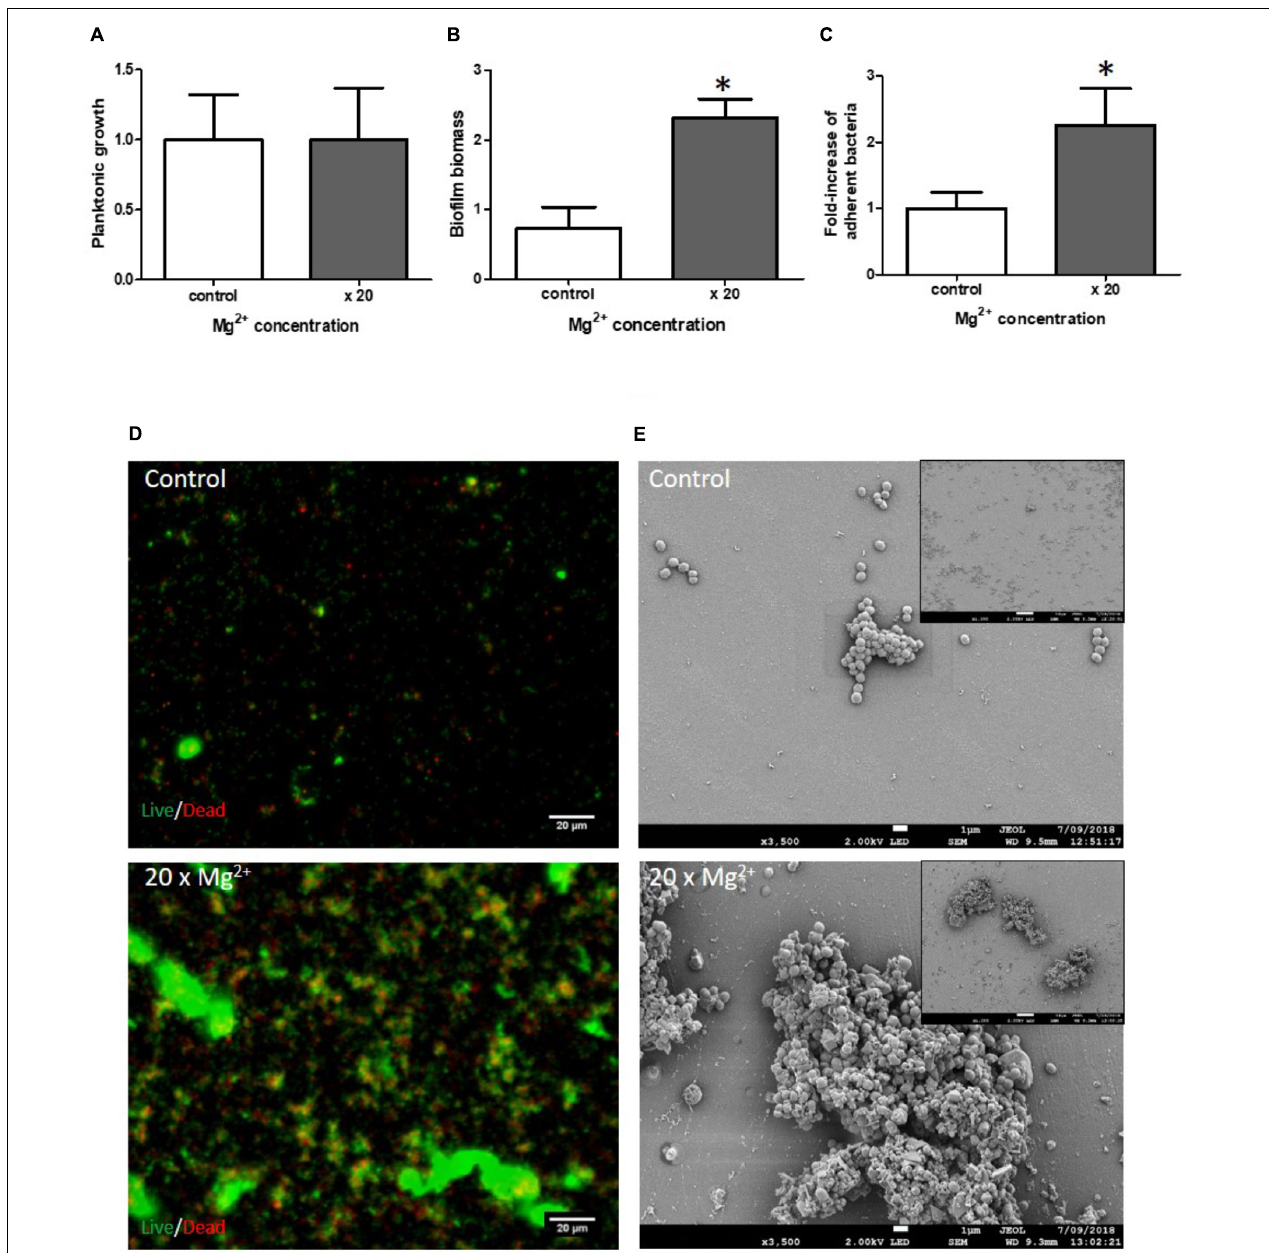
FIGURE 2 | Impact of Mg 2 + on S. aureus biofilm formation. Planktonic growth normalized to control (A) ; biofilm biomass quantified by crystal violet staining (B) and fold-increase of live adhered cells (C) . Mg 2 + × 2 (control) and × 20 serological concentration (=1 mM). ( n = 9). ∗ Statistically significantly different from control ( p < 0.05). Fluorescence microscopy (D) with live (green color)/dead (red color) staining. Scale bar = 20 µ m. Scanning Electronic Microscopy (SEM) (E) . Main panels: scale bar = 1 µ m and insert panels showing the homogeneity on a wide field: scale bar = 10 µ m.